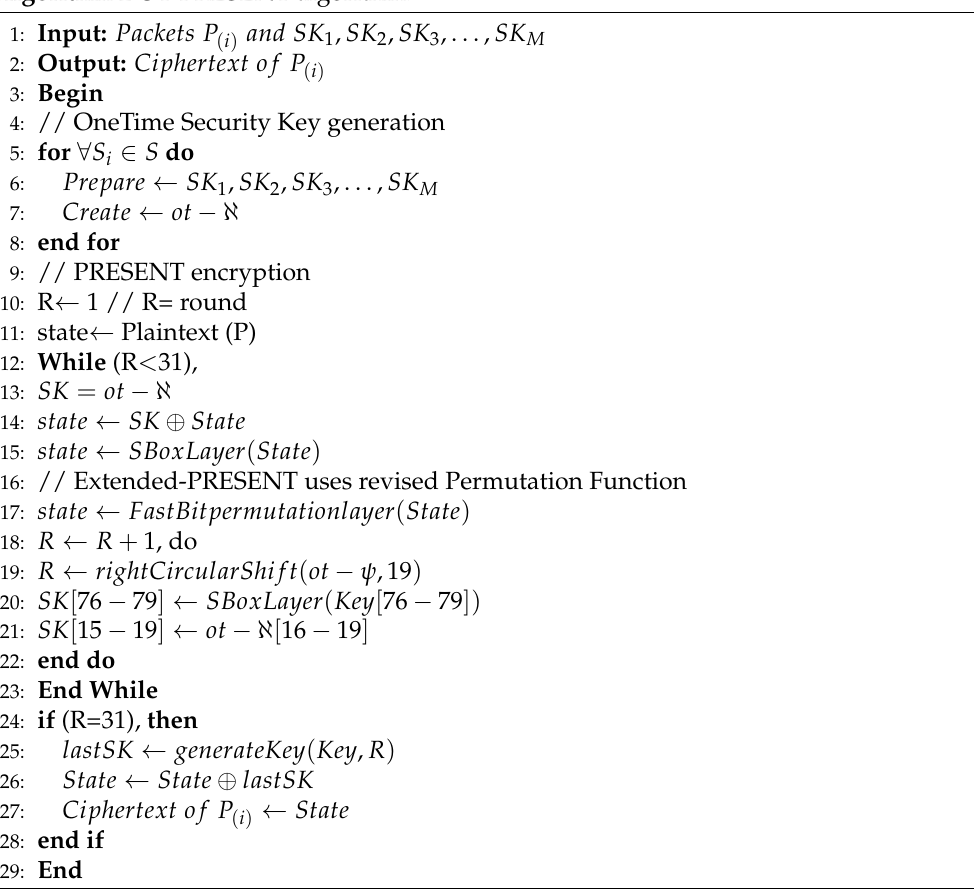
Algorithm 2 OT-PRESENT